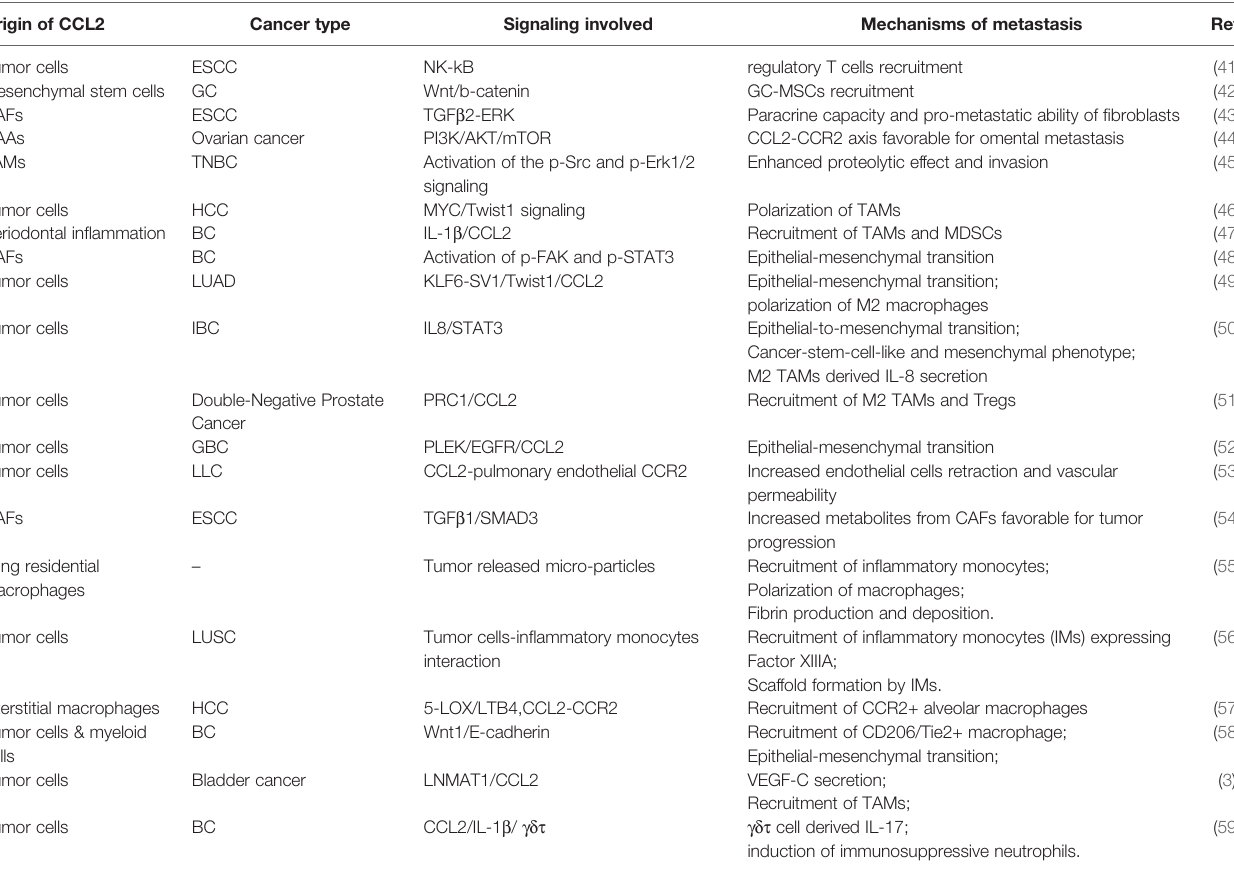
TABLE 2 | The signi fi cance of CCL2 in tumor metastasis. Origin of